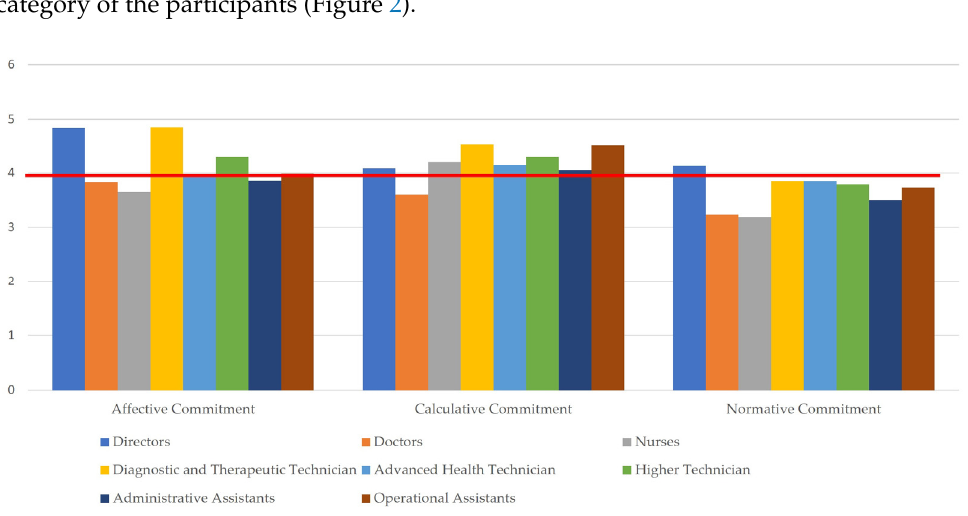
Figure 2. Organisational commitment according to professional category.